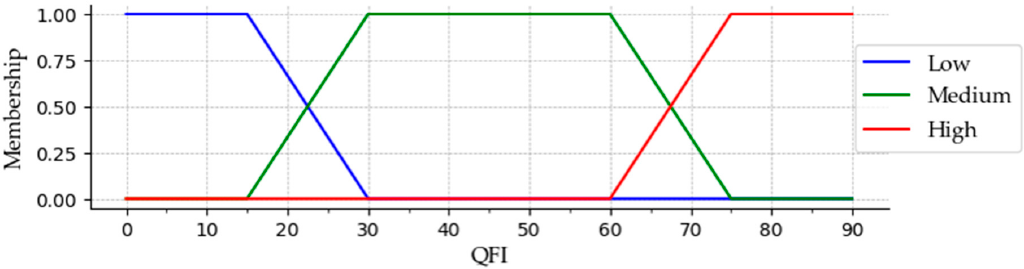
Figure 5. Input variable of queue fluctuation index (QFI). The variable represents the resource availability in a path.